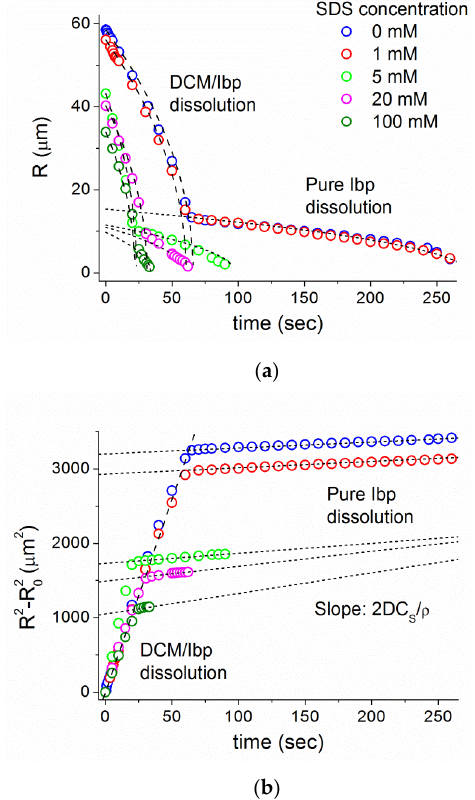
Figure 12. Dissolution profiles of representative microdroplets of 25 mg/mL Ibp in DCM solution injected into 5 mM PBS containing increasing sodium dodecyl sulphate (SDS) concentrations. ( a ) Change of microdroplet radius versus time, where two distinct regions were clearly observed: joint DCM/Ibp dissolution, and pure IBP dissolution; ( b ) Linearized representation where the two regions were fitted by the Epstein-Plesset model (Equation (3)).